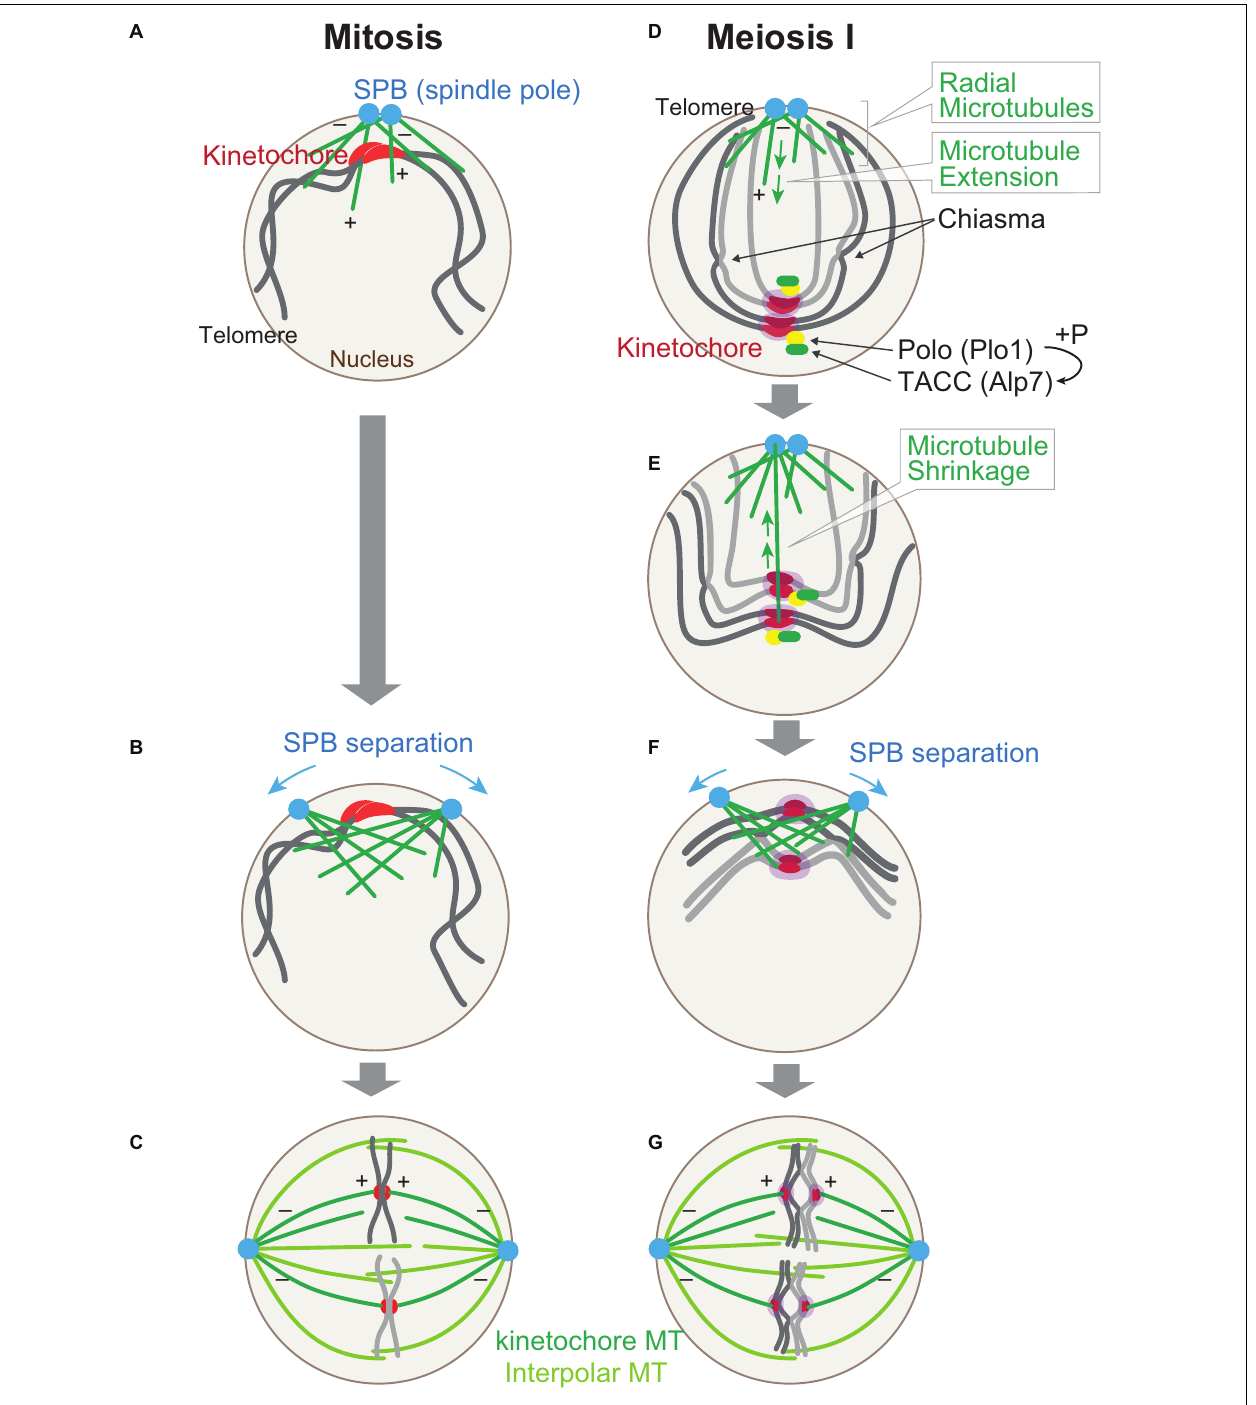
FIGURE 2 | Chromosome arrangement changes upon sexual differentiation. Chromosome positioning upon entry into mitosis. At the onset of mitosis (A) , kinetochores (red) are clustered at spindle pole bodies (SPBs; blue), where microtubules (green) start to nucleate. The polarity of a microtubule is indicated (+, –). SPBs start to separate as the microtubules grow (B) , and in metaphase (C) , kinetochore microtubules (MTs) and interpolar MTs comprise the nuclear spindle. (D–G) Chromosomes are re-arranged upon entry into meiosis I right after the horse-tail nuclear movement is ceased (D) . Microtubules are nucleated from SPBs, but kinetochores are scattered in the nucleus. Kinetochores are mono-oriented by Moa1 (Meikin, purple), which recruits Polo kinase (Plo1). Plo1 then recruits Alp7 (TACC) to pre-attached kinetochores. A radial array of microtubules is formed from SPBs (E) and capture kinetochores and retrieve them toward SPBs. Telomeres are dissociated from SPBs. At the timing when kinetochore retrieval is completed (F) , SPBs start to separate to assemble the bipolar spindle (G) . Note that homologous chromosomes are independently attached to microtubules in mitosis (C) , whereas they are paired in meiosis I (G) .